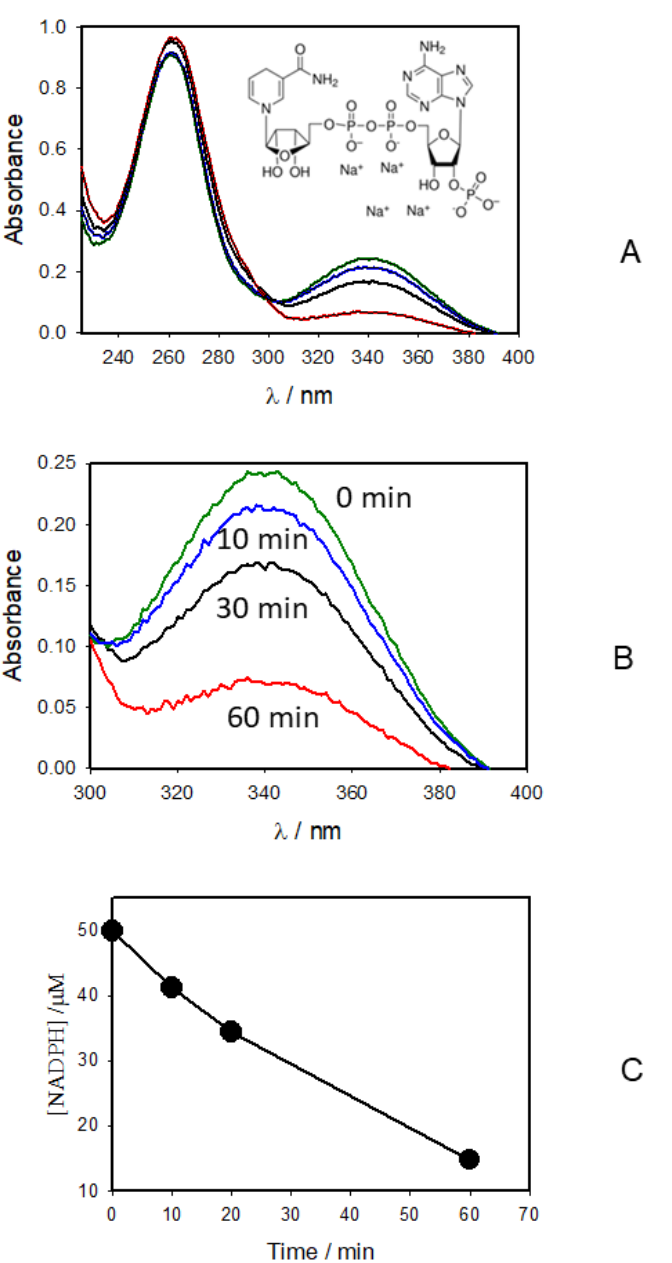
Figure 5. ( A , B ) Absorption spectra of 50 µ M NADPH aqueous solution before (green) and after treatment with cold atmospheric pressure He-plasma jet for 10 min (blue), 30 min (black), and 60 min (red). ( C ) Dependence of NADPH concentration on the CAPPJ irradiation time calculated from the absorption spectra shown in Figure 5B and a calibration curve. The temperature was 20 °C .